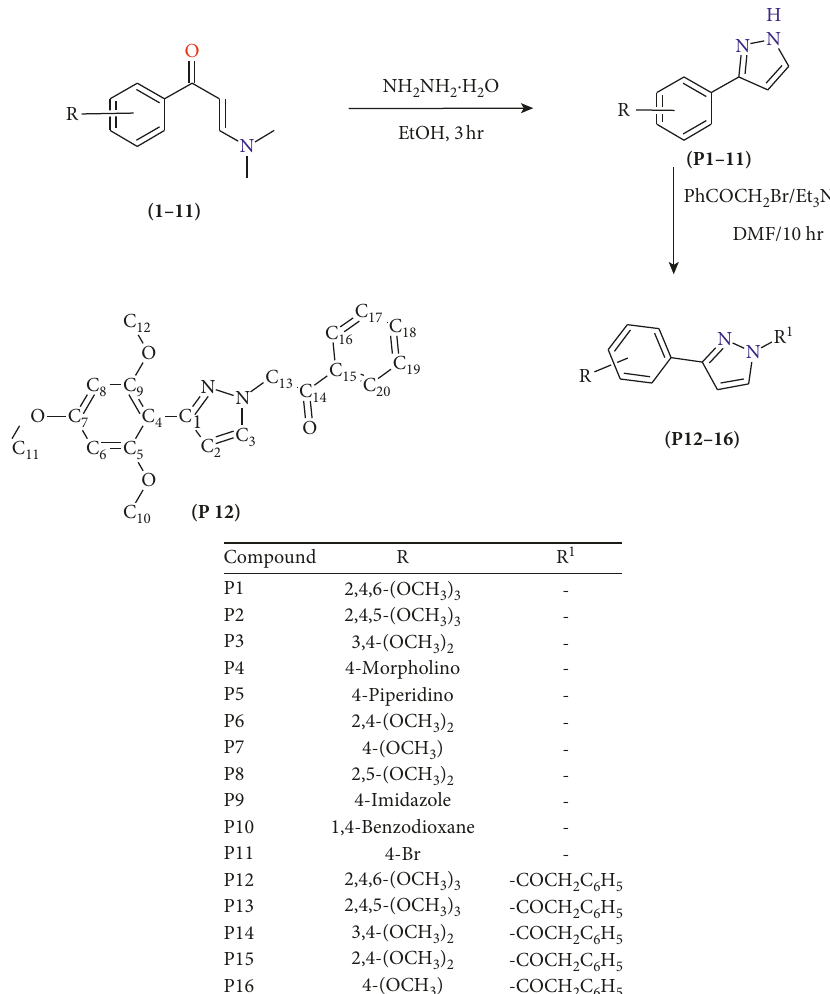
Scheme 1: Synthetic route of compounds ( P1–P16